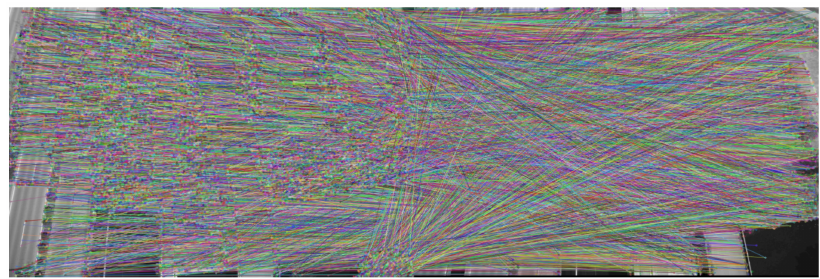
Figure 2. Seed image feature point matching.